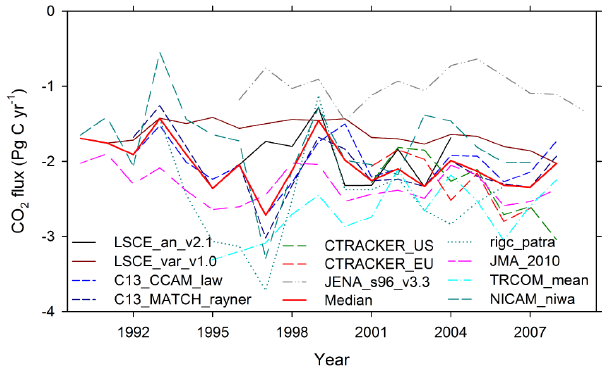
Fig. 6. The 20yr record of annual globally integrated sea–air CO 2 fluxes from the ocean general circulation models, OBGCMs (dashed lines), and ocean inversion estimates (circles with uncer- tainty bars). Similar line types for the OBGCMs indicate that the models have the same heritage. The median (solid red line) is the median of UEA NCEP , LSC, CSI, BER, BEC and ETH k15 model outputs.